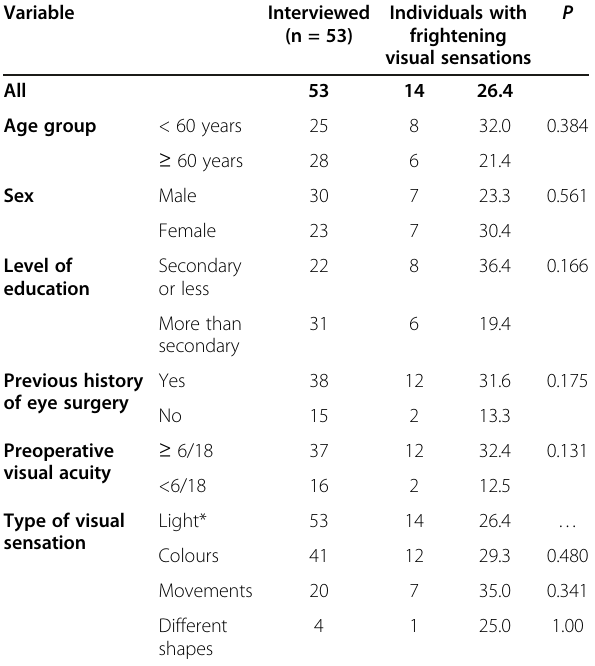
Table 3 Prevalence of frightening visual sensations among study